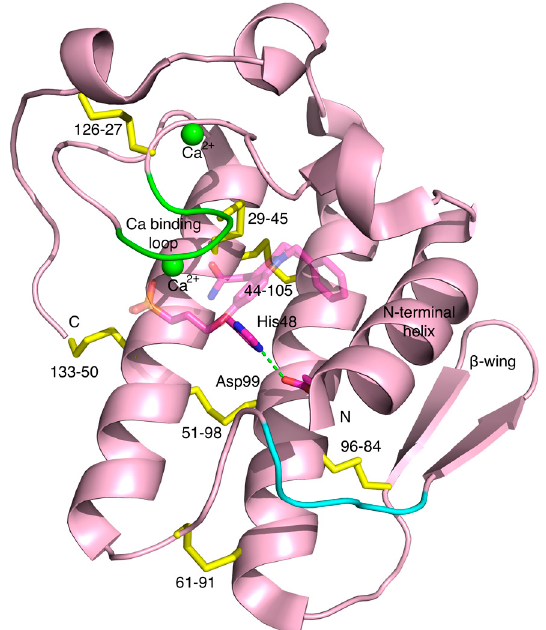
Figure 2. The three-dimensional structure of hGIIA in which the location of some of the functional and structural groups of hGIIA are depicted. The main chain is shown in cartoon style in cerise except for the cysteines in disulfide bonds (yellow), and the calcium binding loop (green) and calcium ions are also shown (green spheres). His48 and Asp99 with carbons in scarlet are the amino acids that constitute the catalytic dyad. The LY311727 inhibitor is also shown, with scarlet carbons and significantly transparent. Overall structure is native hGIIA (PDB ID 3U8B, 2.3 Å resolution [13]), and the LY311727 is superposed from PDB ID 3U8D (1.8 Å resolution) [13]. The region of the endogenous FLSYK sequence is shown in cyan on the cartoon. N and C represent the N- and C-termini, respectively. Figure created with PyMOL [14].